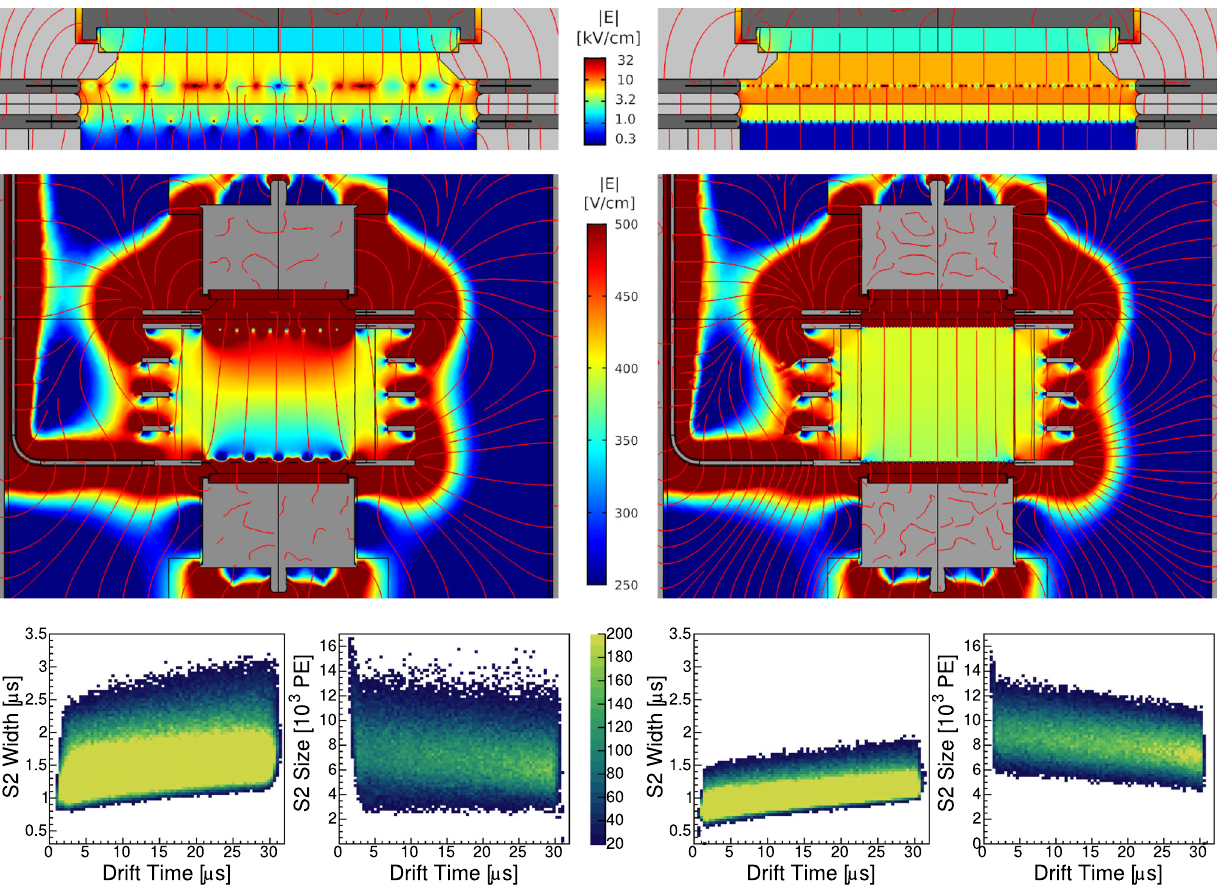
Fig. 5 Simulation results and data from 83m Kr decays for hexagonal grids of 6mm pitch (left) and 1mm pitch (right). The voltages of the individual components are − 900V, + 3750V, − 5V, − 1950V and − 950V for the top PMT, anode, gate, cathode and bottom PMT respectively, yielding a median electric drift-field of about 400V/cm. Top: zoom into the extraction region of the HeXe TPC. Shown is the magnitude of the electric field on a logarithmic scale. Steel and PTFE components are colored in dark and light gray, respectively. Center: magnitude of the electric field inside the drift volume as well as within the PTFE components of the TPC. Steel components are illustrated in gray. Bottom: comparison of the S2 width and S2 area resolution in 83m Kr data acquired with grids of 6mm and 1mm